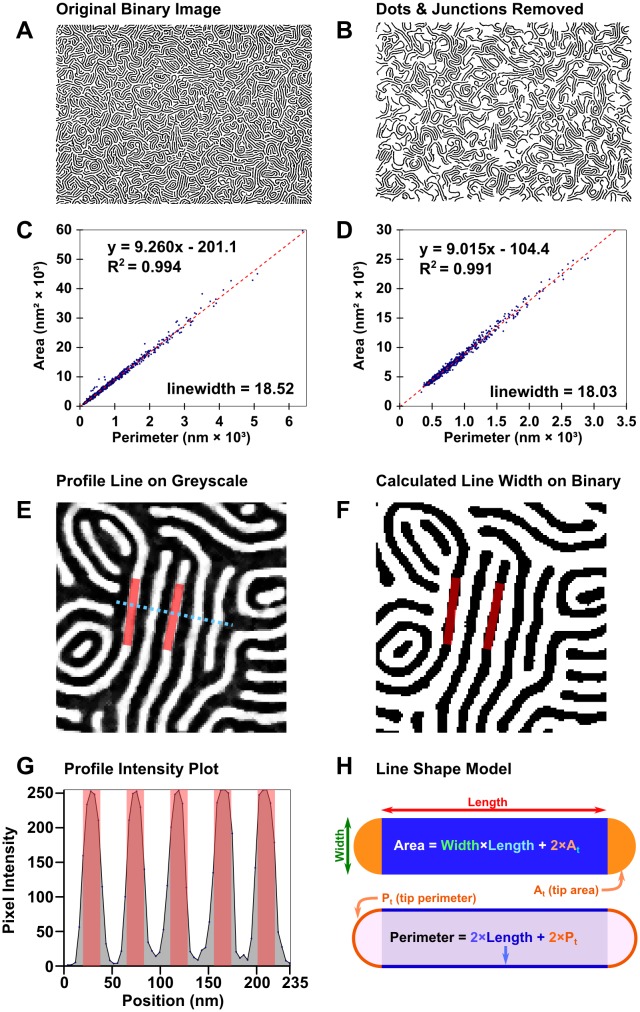
Process for determining line width and period directly from binary patterns.(A) Unmodified binary image of platinized PS(50k)-b-P2VP(16.5k) and (B) simplified binary image; (C) fit of particle area as a function of perimeter for the unmodified image and (D) fit for the simplified image. (E) Demonstration that a fit of 18 nm for line-width is reasonable for the filtered greyscale image, (F) the thresholded binary image, and (G) a profile of the filtered image. (H) Line diagram showing the relationship between particle area, perimeter, and length.